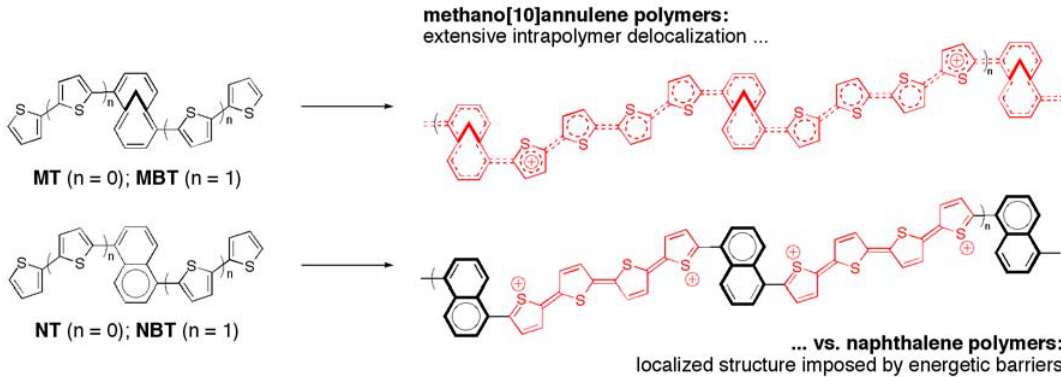
Figure 1. Annulene ( MT and MBT ) and naphthalene ( NT and NBT ) electropolymerizable oligomers (at left), along with the expected polymers formed when n = 1 (at right). The naphthalene is boldened in the aromatic form to emphasize the greater degree of localization observed for naphthyl polymers in their oxidized